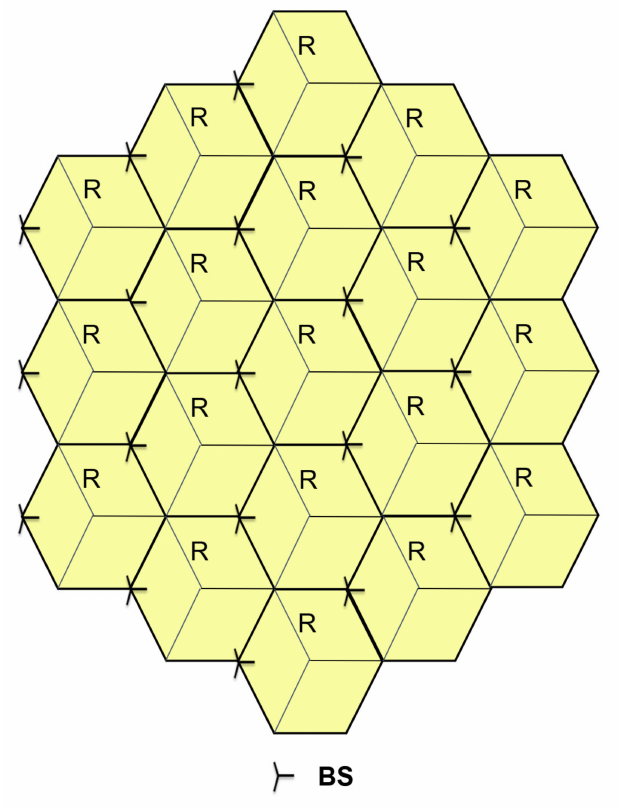
Figure 2. Urban micro scenario layout: Macro layer: ISD = 200 m = 3R; Micro layer: 3 micro TRPs per macro